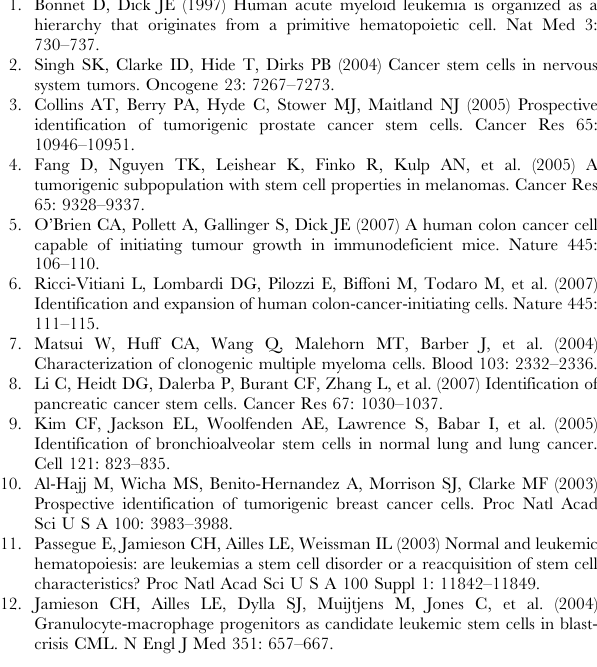
Figure S4 Stem cell marker profiling of primary breast cancer specimen # 235C and the mammosphere and soft agar colony forming efficiency of CD44 + /CD24 2 /low cells compared to other cells from # 235C. A. The prevalence of CD44 + /CD24 2 /low , PROCR + , ESA + , ABCG2 + , CXCR4 + , CD133 + and ALDH + cells were determined using flow cytometry. B. The mammosphere forming efficiency in CD44 + /CD24 2 /low cells was 4-fold higher than other cells. C. The soft agar colony forming efficiency in CD44 + /CD24 2 /low cells was 10-fold higher than other cells. Found at: doi:10.1371/journal.pone.0008377.s004 (0.02 MB PDF) Table S1 Primer sequences. Found at: doi:10.1371/journal.pone.0008377.s005 (0.03